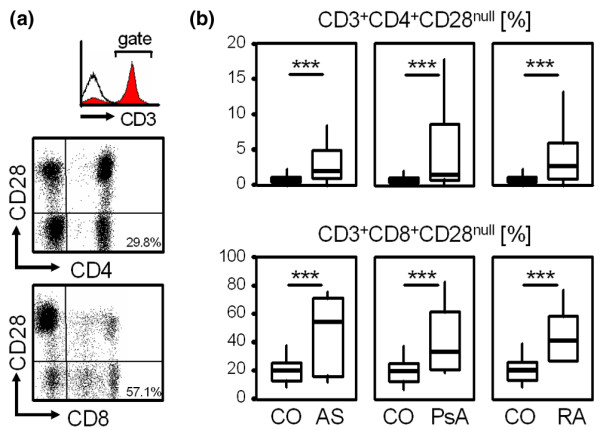
Prevalence of circulating CD3+CD4+CD28null and CD3+CD8+CD28null cells in ankylosing spondylitis, psoriatic arthritis and rheumatoid arthritis. (a) Representative example showing the prevalence of CD3+CD4+CD28null T cells (percentage out of C3+CD4+) and CD3+CD8+CD28null T cells (percentage out of C3+CD8+). The histogram shows staining for CD3 (filled grey curve) and isotype control antibody (black line). Dot plots are then gated on CD3+ cells. (b) Box plots summarize the prevalence of CD3+CD4+CD28null and CD3+CD8+CD28null T cells in ankylosing spondylitis (AS), psoriatic arthritis (PsA) and rheumatoid arthritis (RA) patients. The Mann-Whitney U test was used to determine the statistical differences between patients and the age-matched healthy control group (CO). ***P < 0.001.